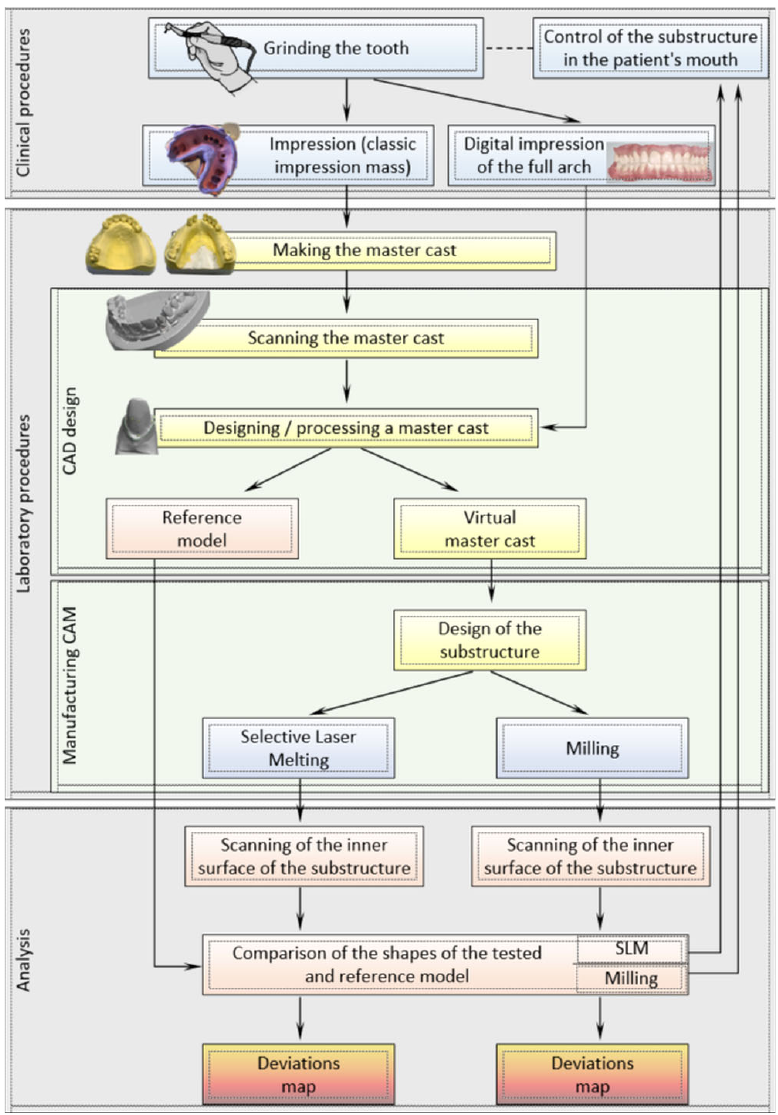
Figure 2. The scheme of the research method.